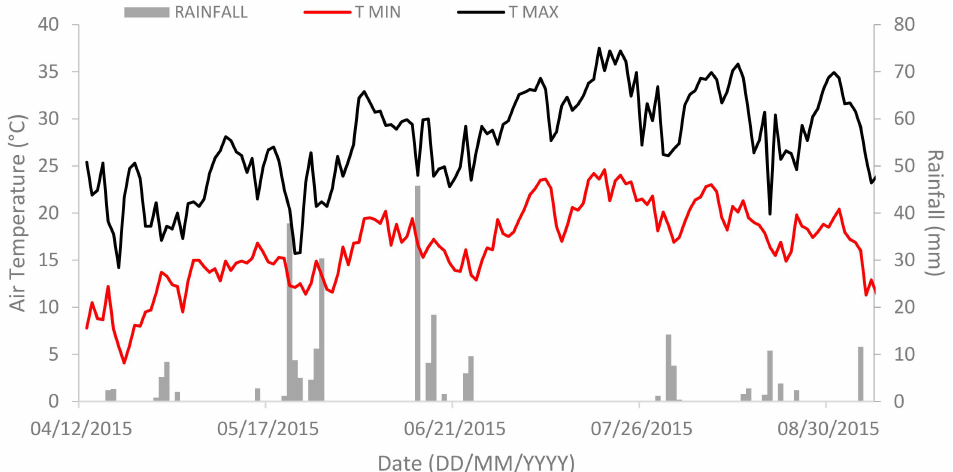
Figure 5. Daily maximum (black line), minimum (red line) air temperature and rainfall (vertical bars) during the 2015 growing season from the Agenzia Regionale per la Prevenzione e Protezione Ambientale del Veneto (ARPAV; http: // www.arpa.veneto.it / ) weather